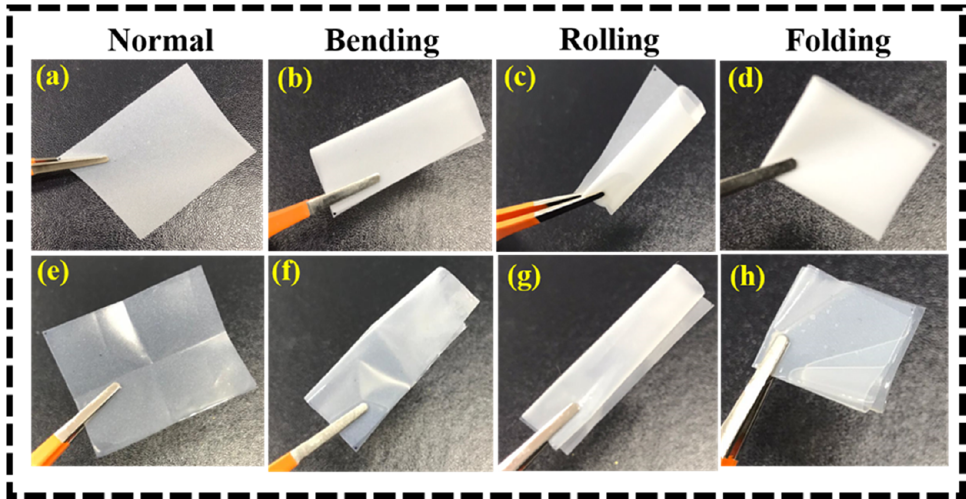
Figure 5. Photographs of PMC electrolyte membrane subjected to flexibility tests at various positions ( a – d ) before and ( e – h ) after immersion into the electrolyte.